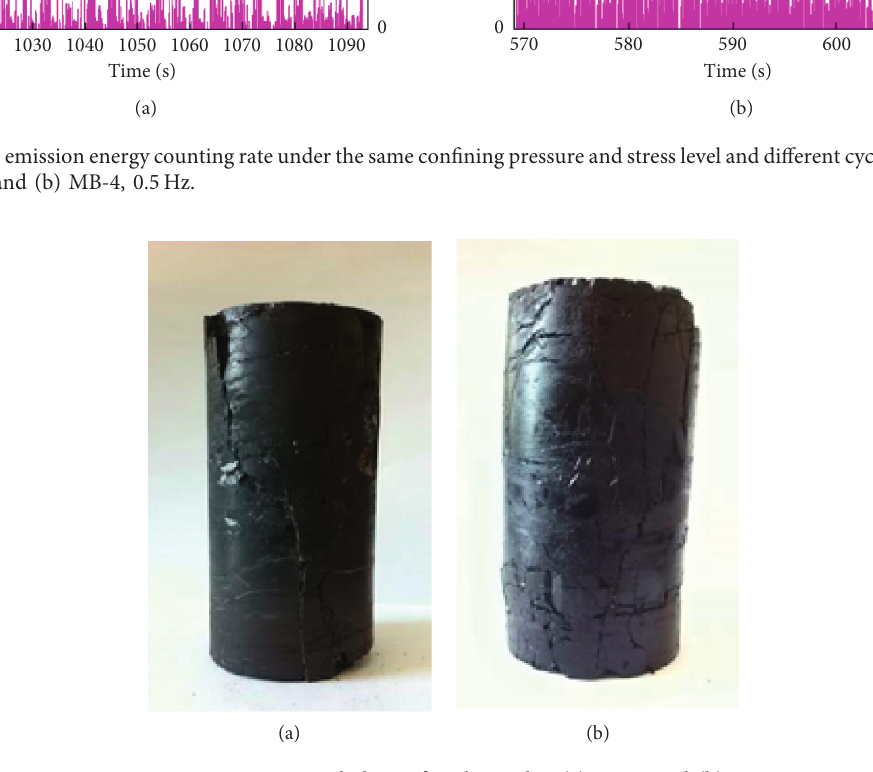
Figure 11: Fracture morphology of coal samples. (a) MA-1 and (b) MB-2. Table 2: Average Felicity ratio of coal samples under cyclic loading.